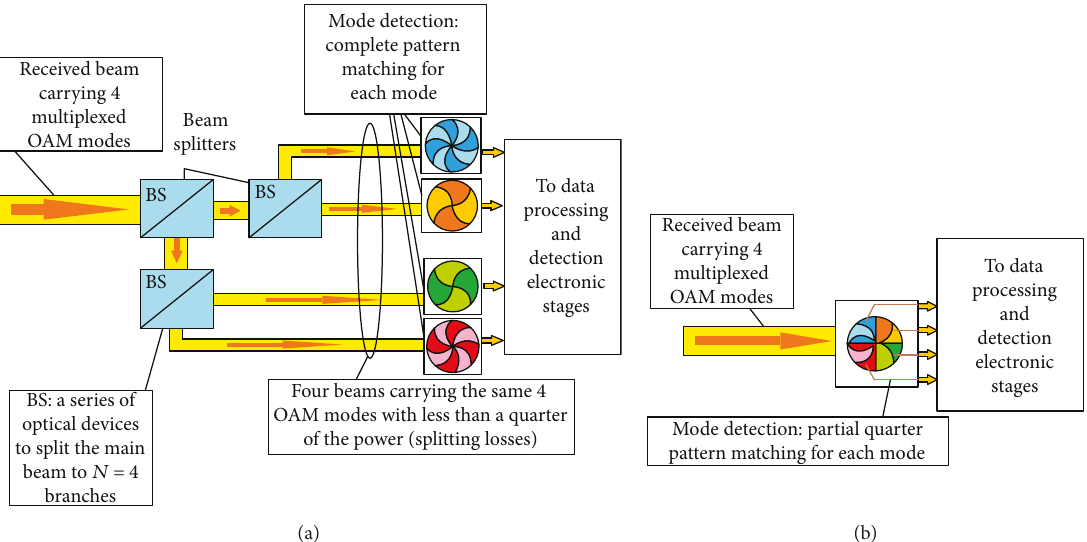
Figure 9: (a) Conventional 4-mode matching receiver with multiple branches. (b) Simpli fi ed receiver with four quadrants and no splitting devices.